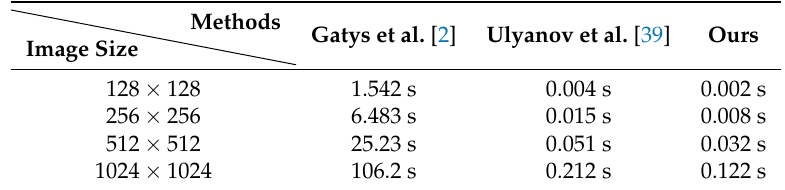
Figure 12. Example results of style transfer using our image transformation networks. (left) Input image; (middle) results of Ulyanov et al. [39]; (right) ours. Table 5. Speed (in seconds) for our style transfer network vs. the optimization-based baseline for varying numbers of iterations and image resolutions. Both methods are benchmarked on a GTX 1080